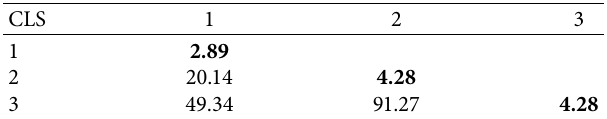
Figure 4: Clustering of the 32 faba bean samples evaluated in the present study. Table 11: Inter- and intra- (diagonal element and bold) cluster distance of the tested